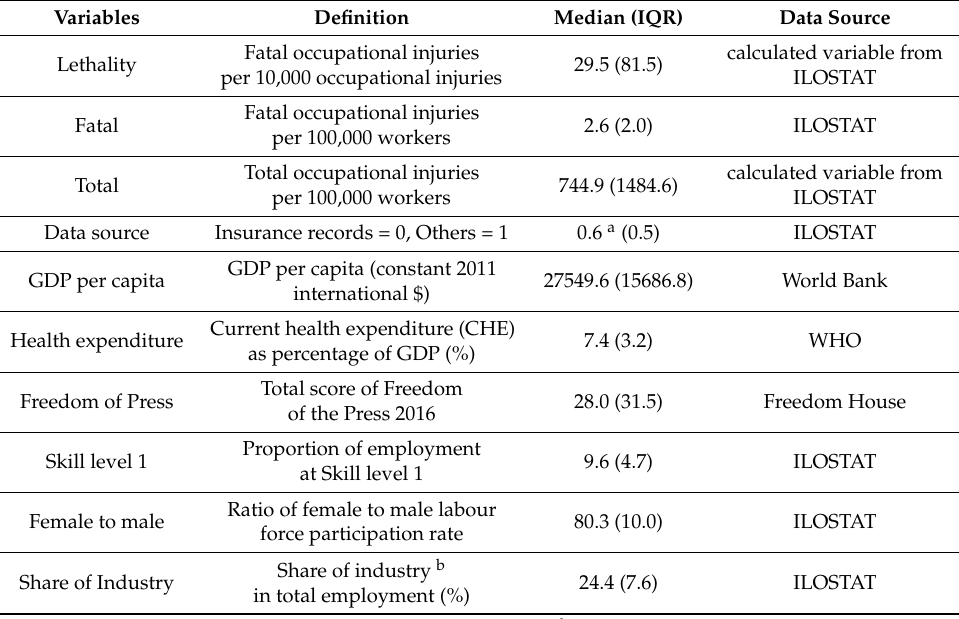
Table 1. Variable definitions and summary statistics in the year 2015 among 39 countries.